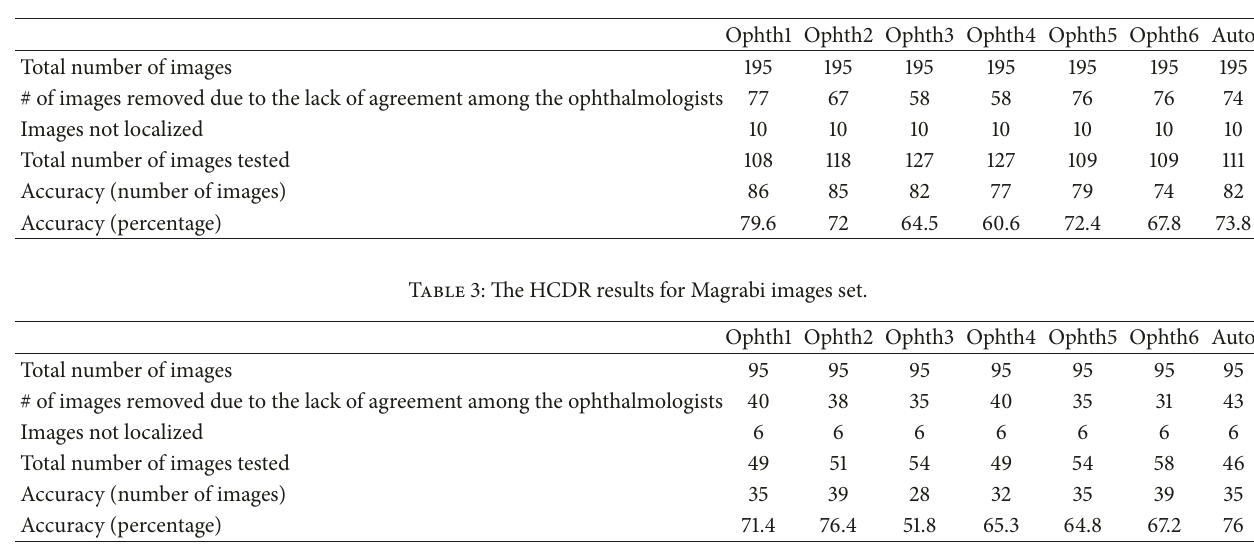
Figure 4: Examples of good segmentation results for horizontal cup to disc ratio. Each row shows the results for a sample image. The images on each row show the results of manual markings by the six ophthalmologists (1 to 6; left to right) and the automatic marking by the algorithm (far right). Table 2: The HCDR results for Bin Rushed images set.